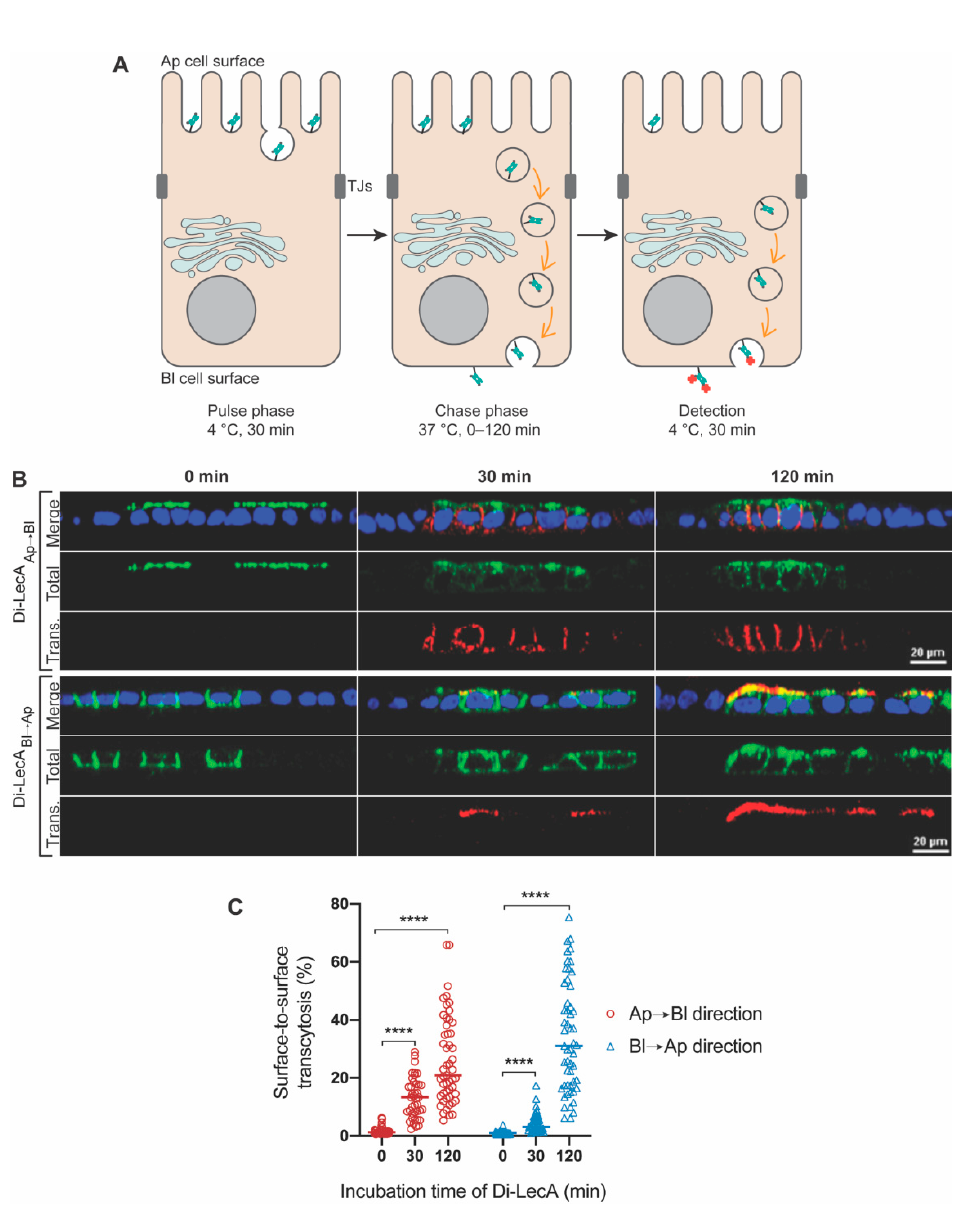
Figure 1. Surface-to-surface transcytosis of Di-LecA. ( A ) A schematic illustration of the applied ‘Pulse-Chase’ assay. The biotinylated lectin was, in addition, labeled with the fluorophore AF488, which is shown in green color in the scheme. Di-LecA-biotin-AF488 was pre-bound to the Ap or the Bl cell surface for 30 min at 4 ◦ C. Excess Di-LecA-biotin-AF488 was removed by washing with ice-cold medium. Cells were shifted to 37 ◦ C for the indicated incubation periods: 0 min, 30 min, and 120 min, respectively. After the incubation, cells were cooled to 4 ◦ C, and Di-LecA arrival was detected by using streptavidin-AF647, shown in red color in the scheme. ( B ) Transcytosed Di-LecA- biotin-AF488 (green) was measured. Representative cross-sections of acquired z-stack images are shown. Cell-surface-bound Di-LecA-biotin-AF488 was detected by using streptavidin-AF647 (red) from the opposite side (scale bar: 20 µ m). ( C ) The surface-to-surface transcytosis efficiencies of Di-LecA were quantified. The Mann–Whitney test was used to calculate the significant difference between groups. Mean values are shown. **** p < 0.0001. For each time point, the included individual cell number n was greater or equal to